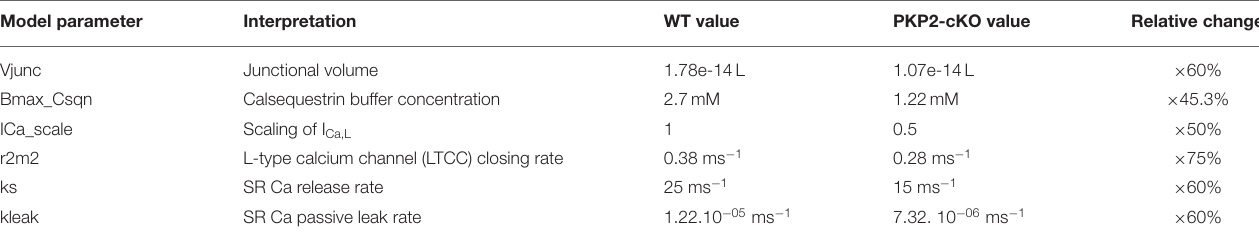
TABLE 1 | Summary table of the parameters changed in the original model (Morotti et al., 2014) to simulate the PKP2-cKO experimental characteristics, their interpretation, their values in the original WT and PKP2-cKO model and the relative change between WT and PKP2-cKO. Model parameter Interpretation WT value PKP2-cKO value Relative change Junctional volume